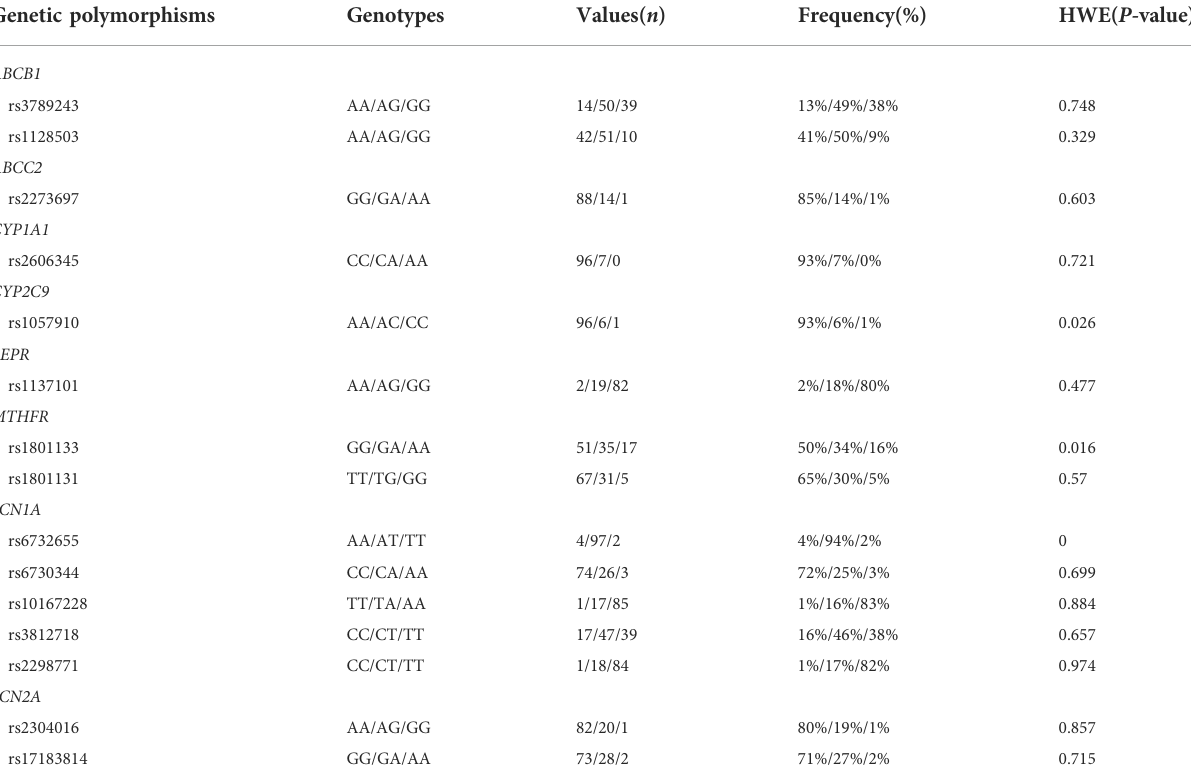
TABLE 2 Genotype frequencies of selected variants in 103